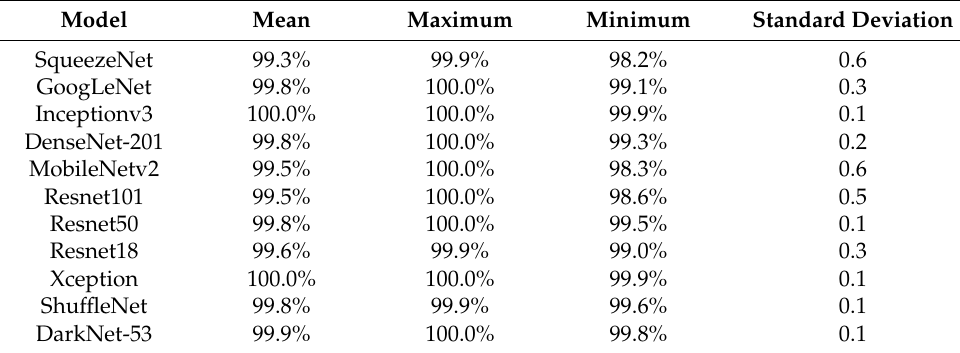
Figure 3. Examples of the confusion matrices for ResNet101 and DarkNet-53 models using 80% of the data for training. Table 5. The mean, minimum, maximum, and standard deviation of the accuracy taken over 10 runs and using 80% of the data for